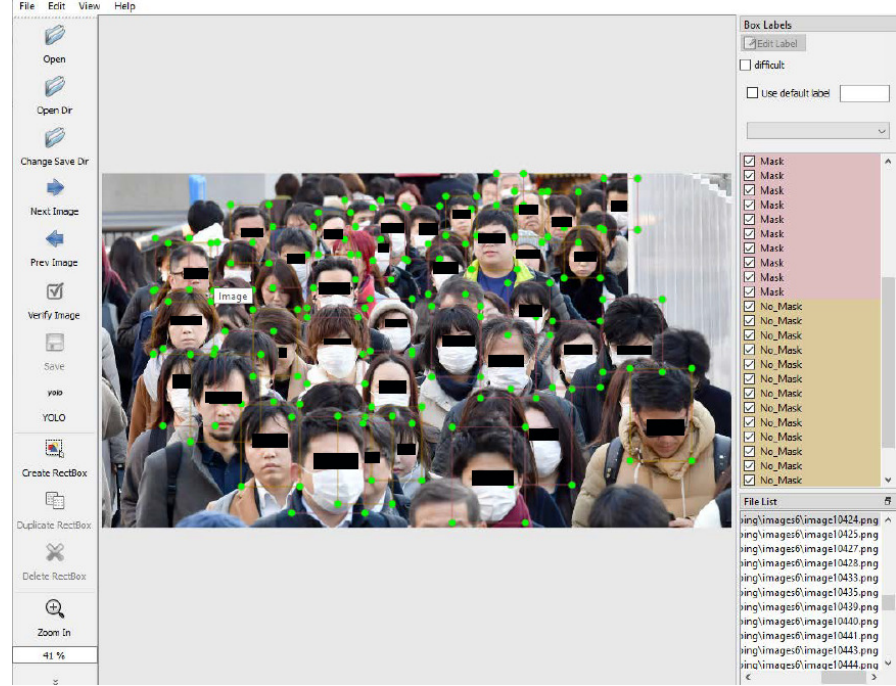
Figure 3. Label assignment using LabelImg in an image with many faces of both categories ( Mask and No_Mask